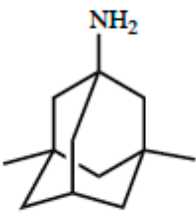
Figure 3. Chemical structures of HMG-CoA reductase inhibitors (i.e., Statins).